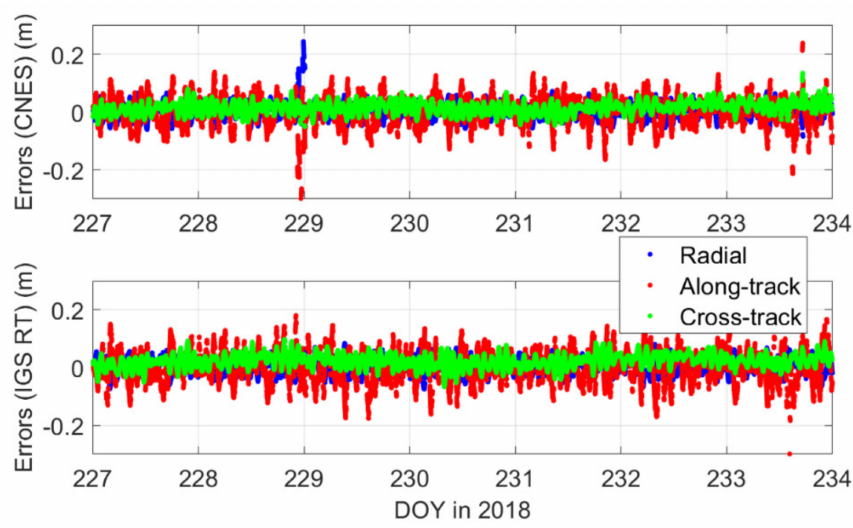
Figure 5. Connected orbital errors predicted for 6–11 min for Sentinel-3B from 15 to 21 August 2018. The CNES real-time products ( top ) and IGS RTS products ( bottom ) were used for the processing.